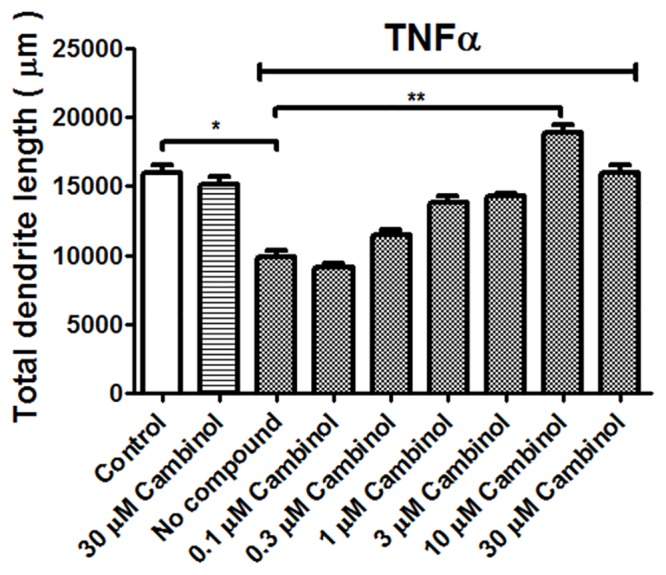
Effect of cambinol on TNF-α-induced decrease in dendrite length of rat primary hippocampal neurons.Cells were treated with cambinol (0.1–30 μM) and TNF-α (100 ng/ml) for 18 h. Dendrite length was assessed by imaging of MAP-2 stained cells using Neurolucida software. Results shown are the average of 5–6 experiments. Error bars correspond to S.E.M. * p < 0.05 and ** p < 0.01.